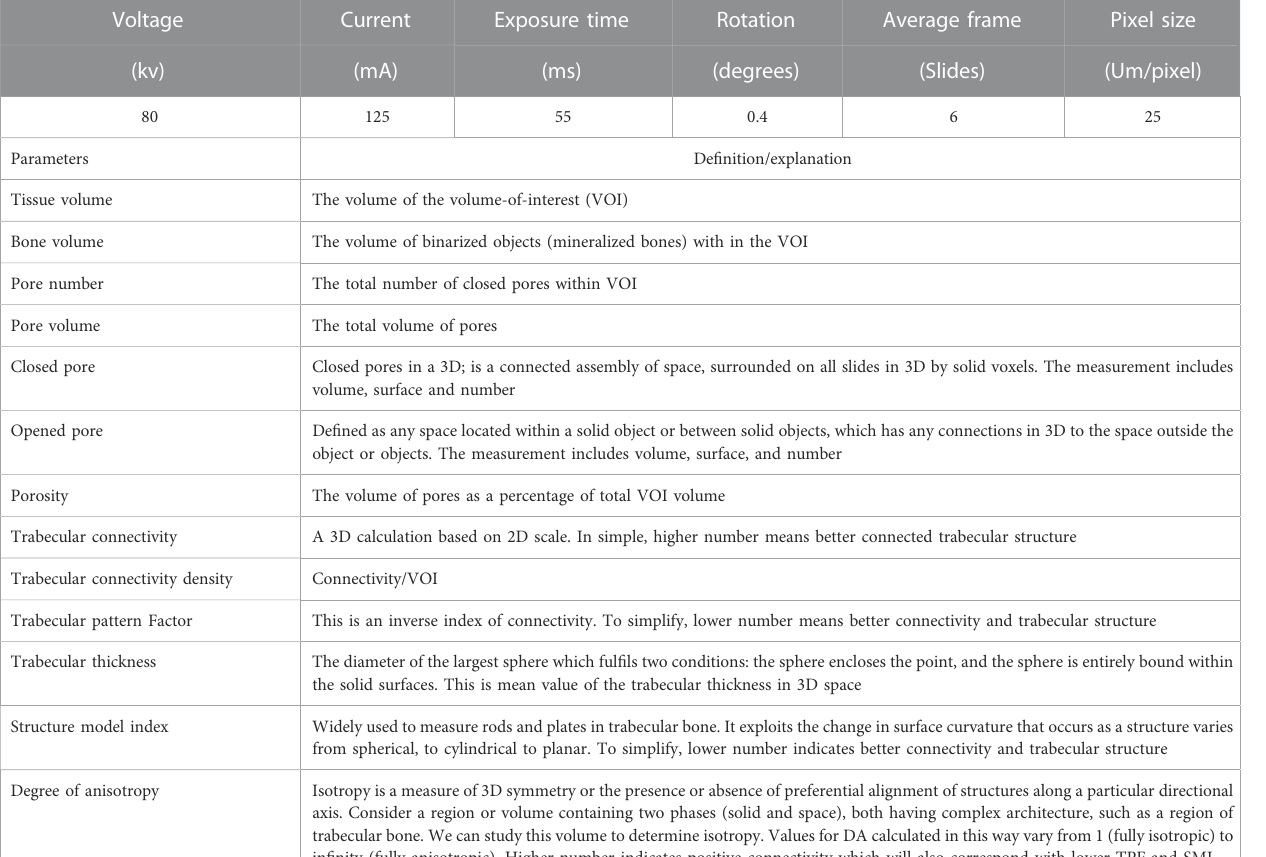
TABLE 3 Micro-CT scanning settings and de fi